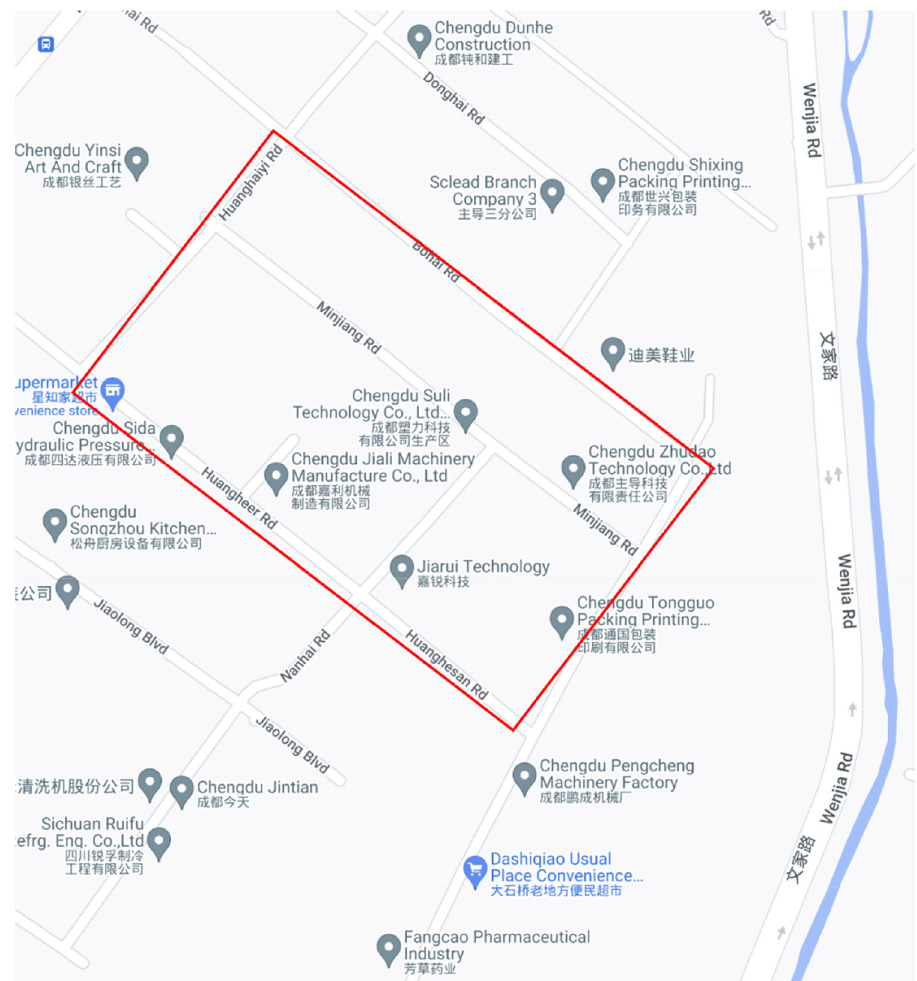
Fig 8. Location of the renovation project of Wenjia Street in Qingyang District, Chengdu